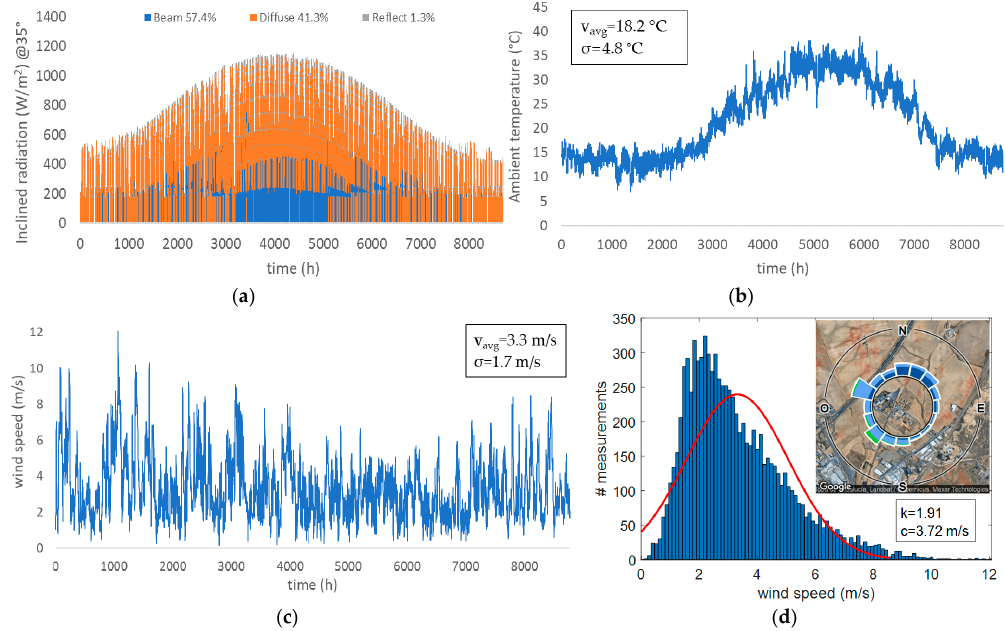
Figure 18. Annual meteorological data on the microgrid location (Huelva, southwest of Spain). (a) Inclined solar radiation and its components; (b) ambient temperature—mean and standard deviation ( σ ); (c) wind speed (W10)—mean and standard deviation ( σ ); (d) wind statistical analysis—Weibull distribution and fitting—shape (k) and scale (c) factor.